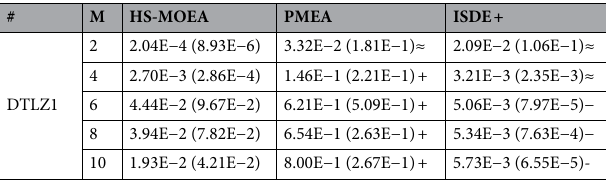
Table 3. Comparison of GD.